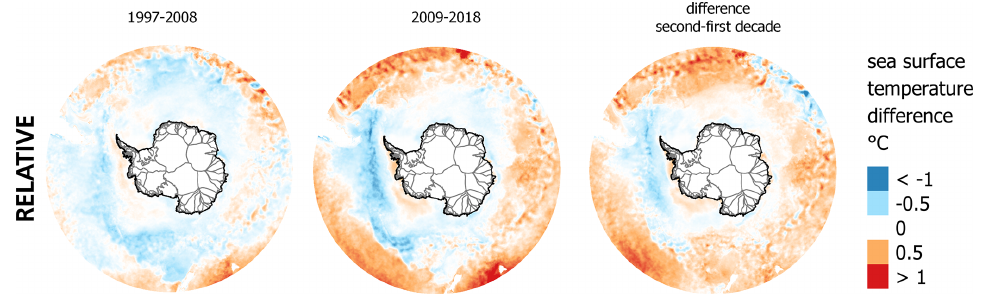
Figure 5. Mean sea surface temperature changes (October–March) compared to 1982–1996 and the difference in sea surface temperatures between both decades.